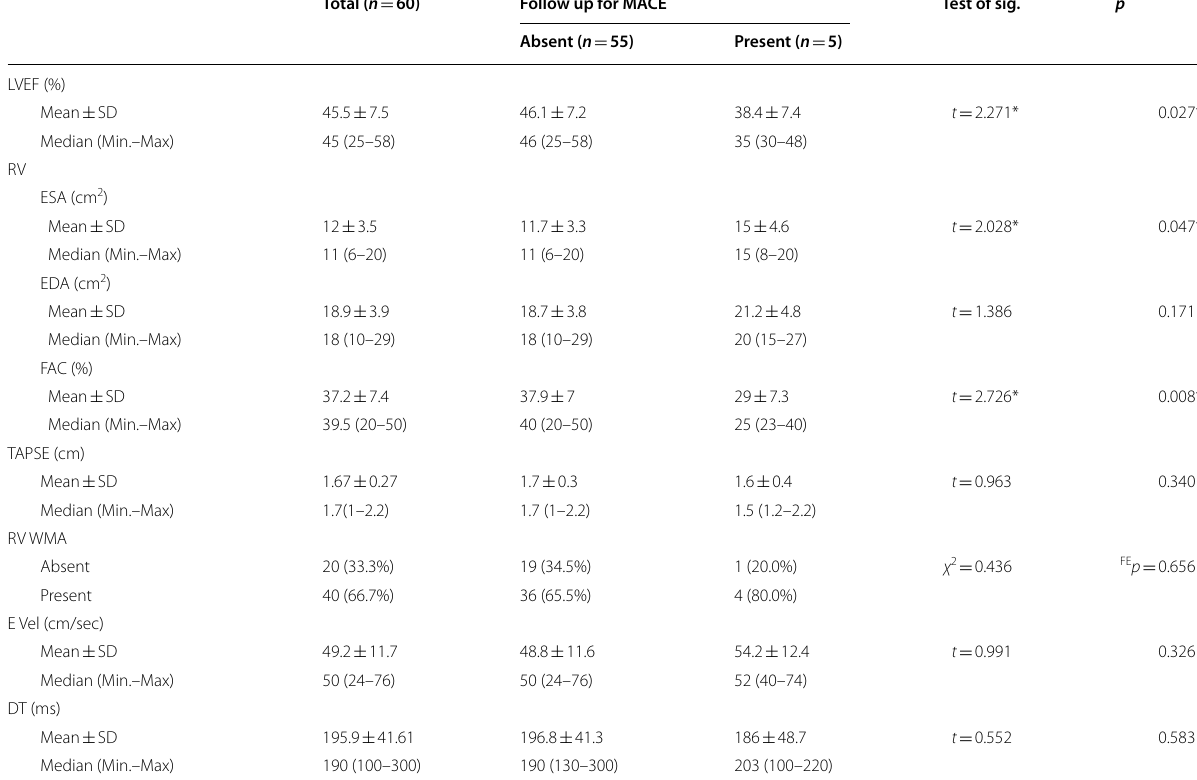
Table 2 Comparison between MACE and non-MACE groups regarding echocardiographic parameters Total ( n =